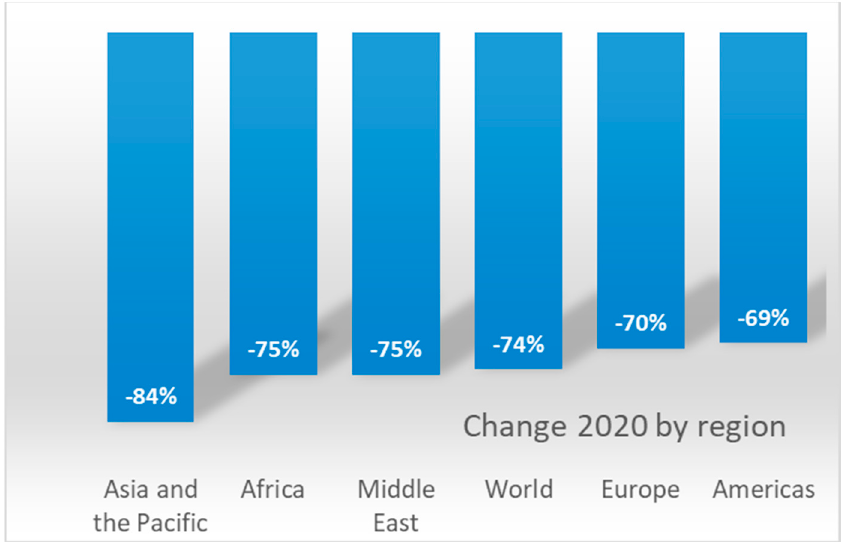
Figure 1. Tourists arrivals decrease in 2020 by world regions. Source: World Tourism Organization (UNWTO) January